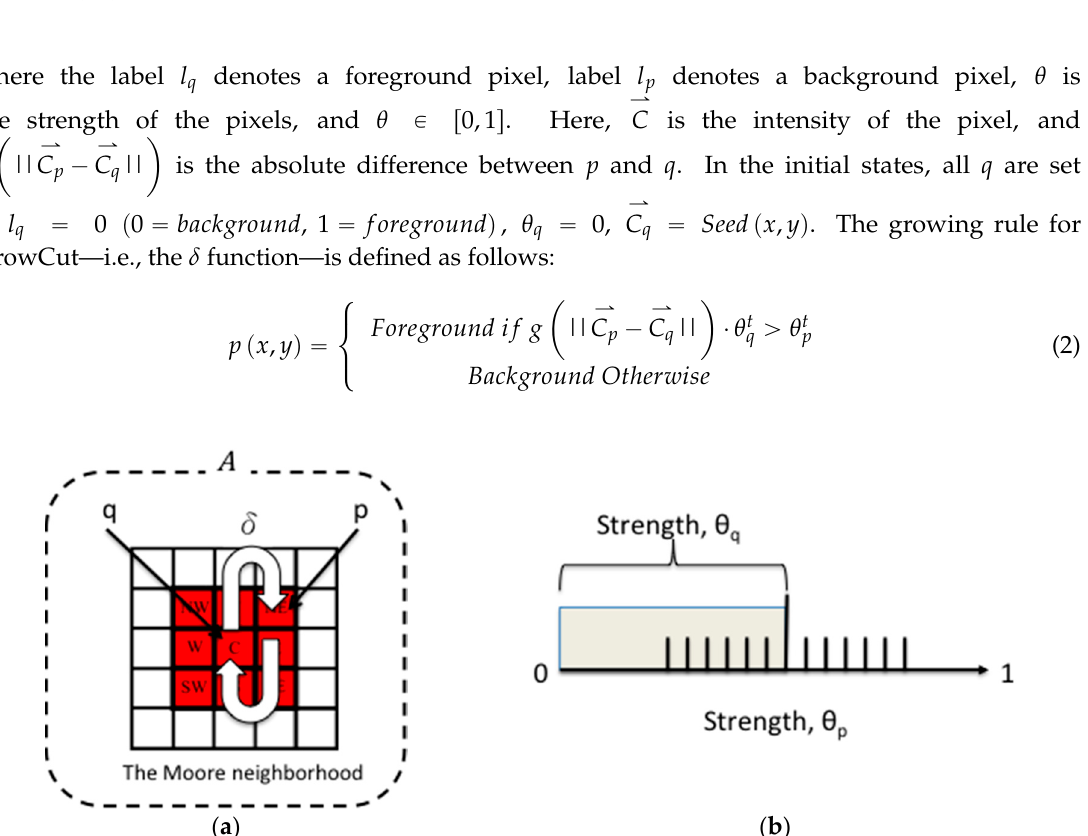
Figure 3. ( a ) Region-growing process from cell q to its neighbors or reverse-growing from its neighbors, with the δ function; and ( b ) the strength threshold for the growing rule. The region grows when θ q ą θ p ; otherwise the region reverse-grows.